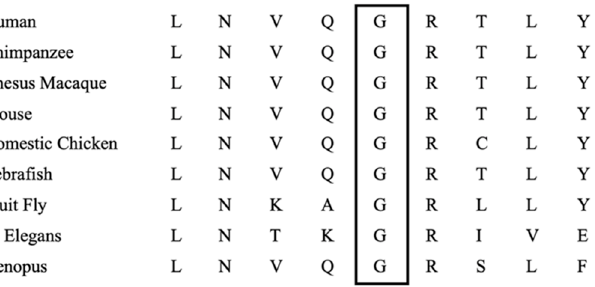
Figure 2. Protein sequence alignment showing 100% conservation of the Gly104 residue (rectangle) across all reported IBA57 homologs.